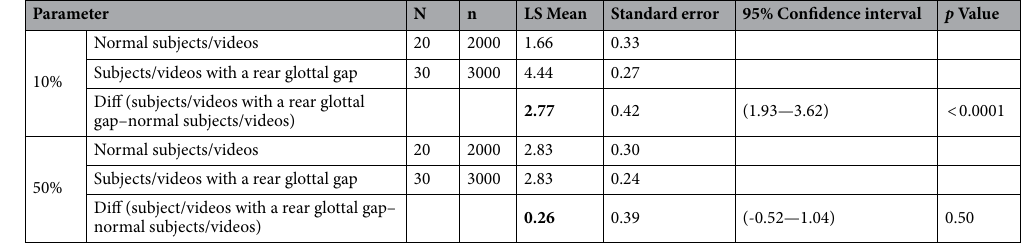
Table 1. Data were analyzed in a linear mixed-effect model using REML, including the group (glottal gap/normal) as a fixed effect and the subject as a random effect; N number of subjects; and n number of observations. The group differences between the subjects with a rear glottal gap and the normal subjects are presented as least-squares means (LS means) with a corresponding 95% confidence interval. The mixed linear model was used because it is an extension of simple linear models to allow for both fixed and random effects, particularly used when there is nonindependence of the data. The SAS statistics show a difference between the 10% lines measured in pixels. Significant values are in